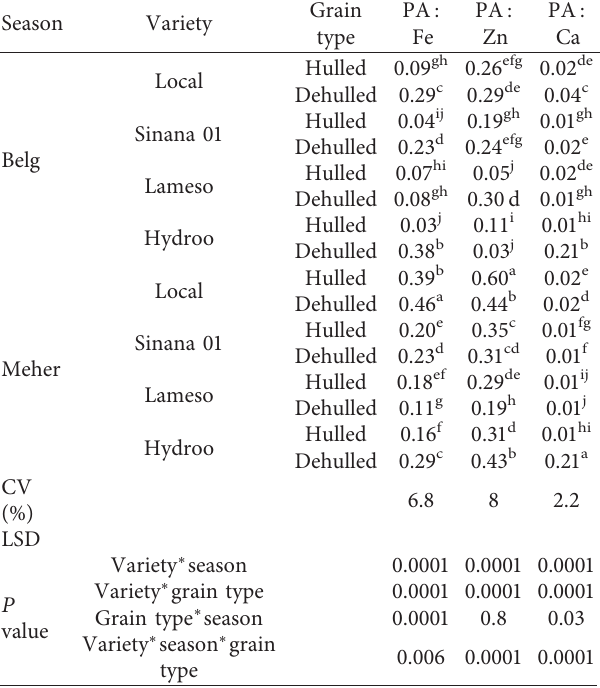
Table 4: Bioavailability of iron, zinc, and calcium in emmer wheat grains as affected by grain types, growing seasons, and varieties. Season